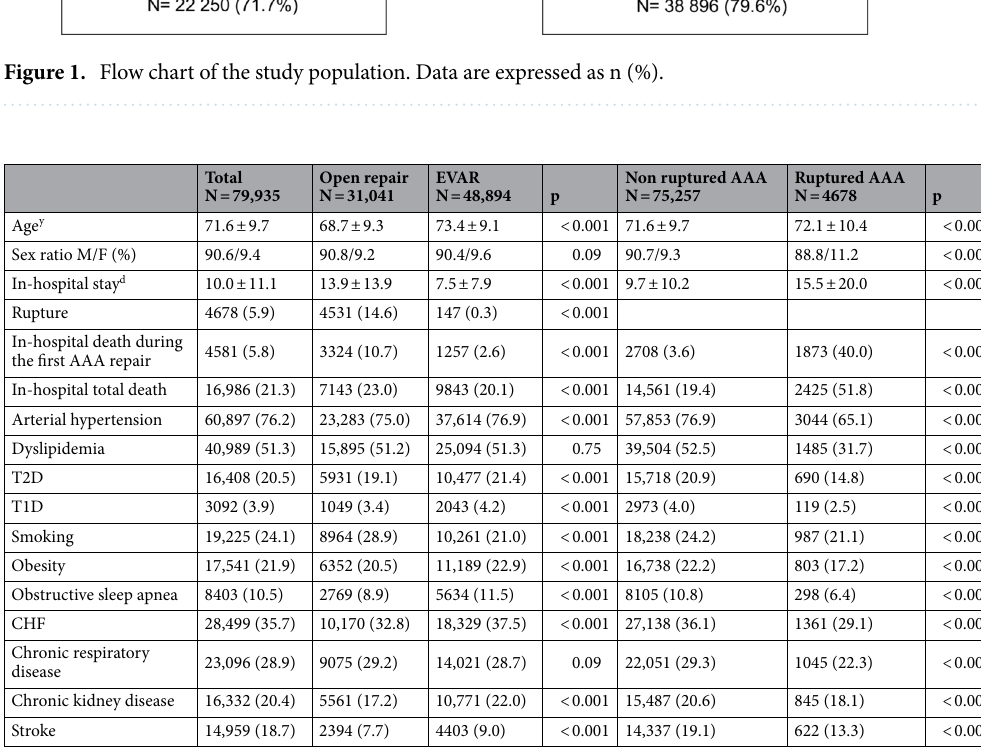
Table 1. Characteristics of patients operated for an abdominal aortic aneurysm classified according to the type of surgery and the presence of a rupture. Results are expressed as mean ± SD or n (%). AAA abdominal aortic aneurysm, CHF congestive heart failure, d days, EVAR endovascular aneurysm repair, F female, M male, T1D type 1 diabetes, T2D type 2 diabetes, y